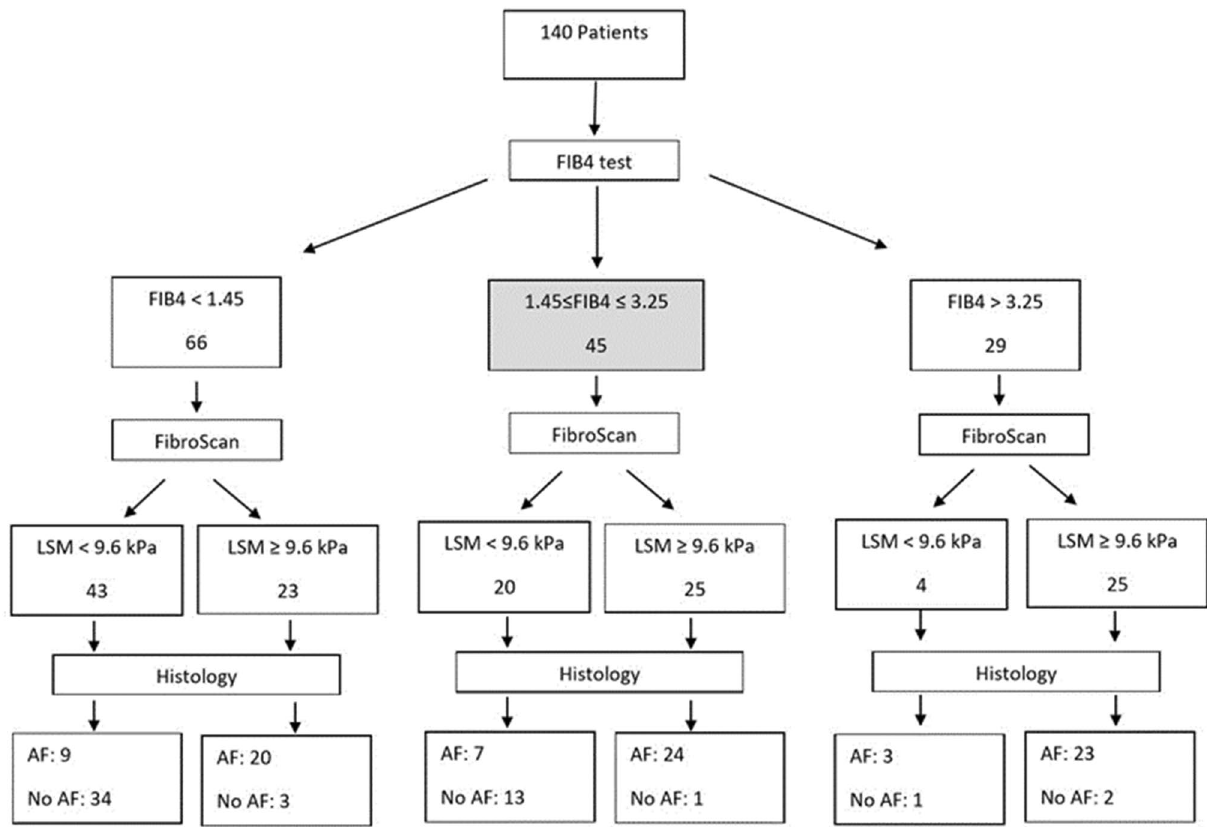
Figure 2. Algorithm 2: Non-invasive approach using FIB-4 and VCTE for assessment of advanced fibrosis in patients with chronic liver disease. First non-invasive test FIB-4 <